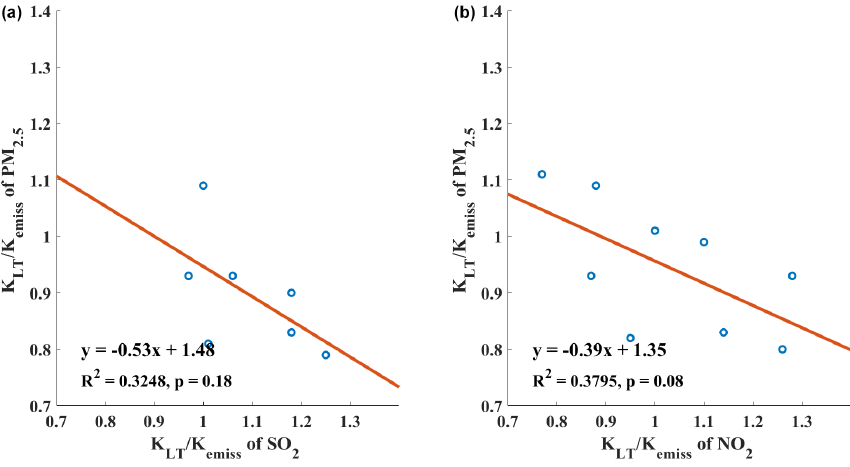
Figure 8. Scatter plots of the ratios between k LT and k emiss of (a) SO 2 , (b) NO 2 and PM 2 . 5 in the THB from 2015 to 2019 with red lines for the linear fitting